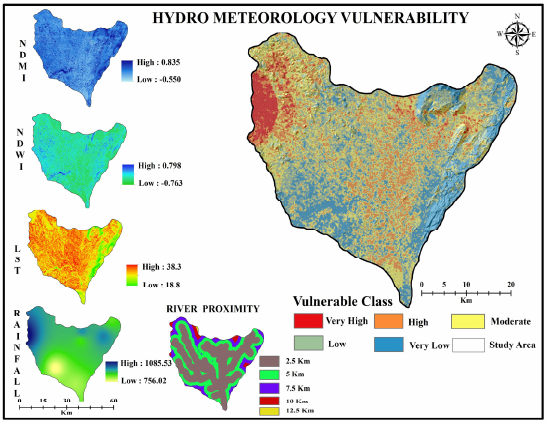
Figure 3. Hydro-Meteorological Vulnerability